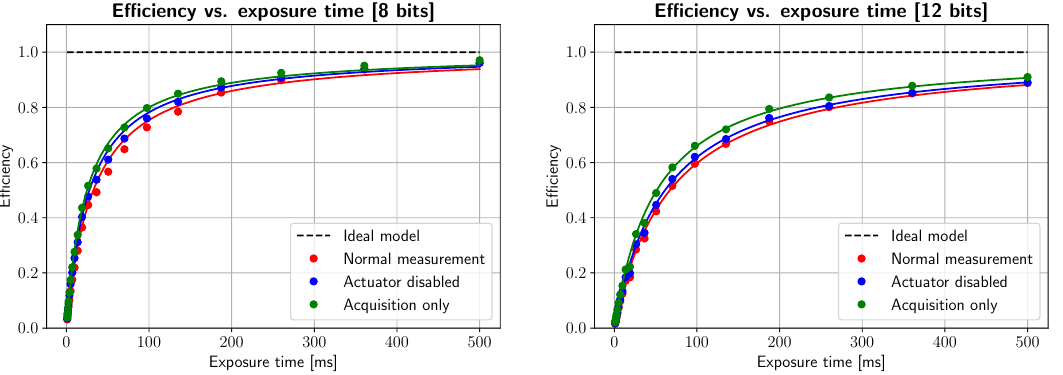
Figure 13. Measured system efficiency and nonlinear least squares fit, as defined by Equation (3) for 8- and 12-bit depth. As exposure time increases, the fraction of time spent in camera communications becomes negligible and efficiency increases. This is also increased with bit depth, as the data must traverse a bandwidth-limited network. As can be seen, mirror rotation and memory buffering produces a noticeable decrease in efficiency of about 10% for typical exposure times (100–300